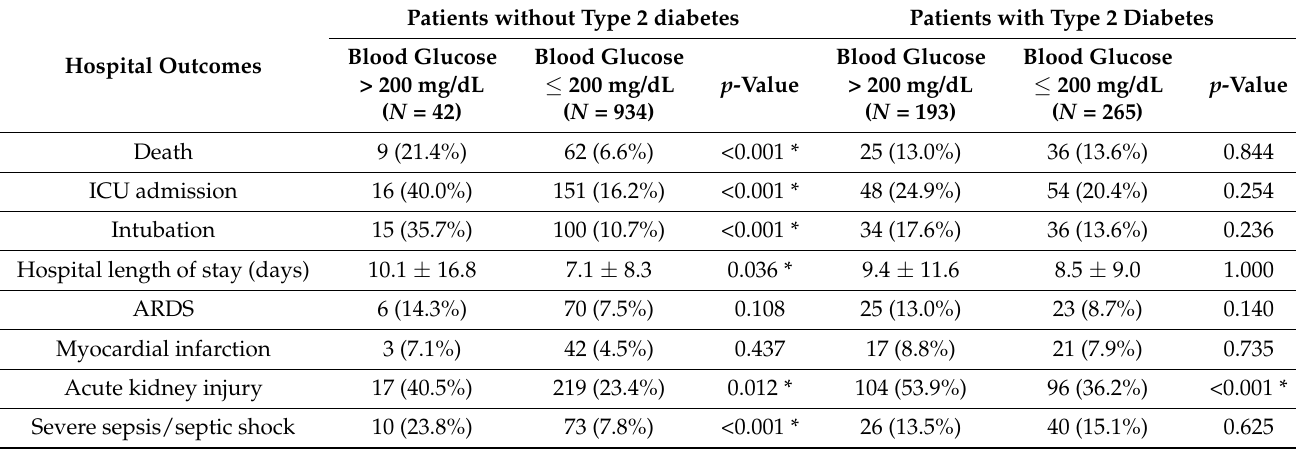
Figure 1. Comparisons of inflammatory markers among patients with and without type 2 diabetes who had admission blood glucose ≤ 200 and >200 mg/dL. ( A ) C-reactive protein ( B ) Erythrocyte sedimentation rate ( C ) D-dimer ( D ) Ferritin ( E ) Lactate dehydrogenase. “*” denotes p < 0.05; “**” denotes p < 0.01; “***” denotes p < 0.001. Table 2. Univariate comparisons of hospital outcomes between patients with admission blood glucose >200 mg/dL and ≤ 200 mg/dL among patients with and without type 2